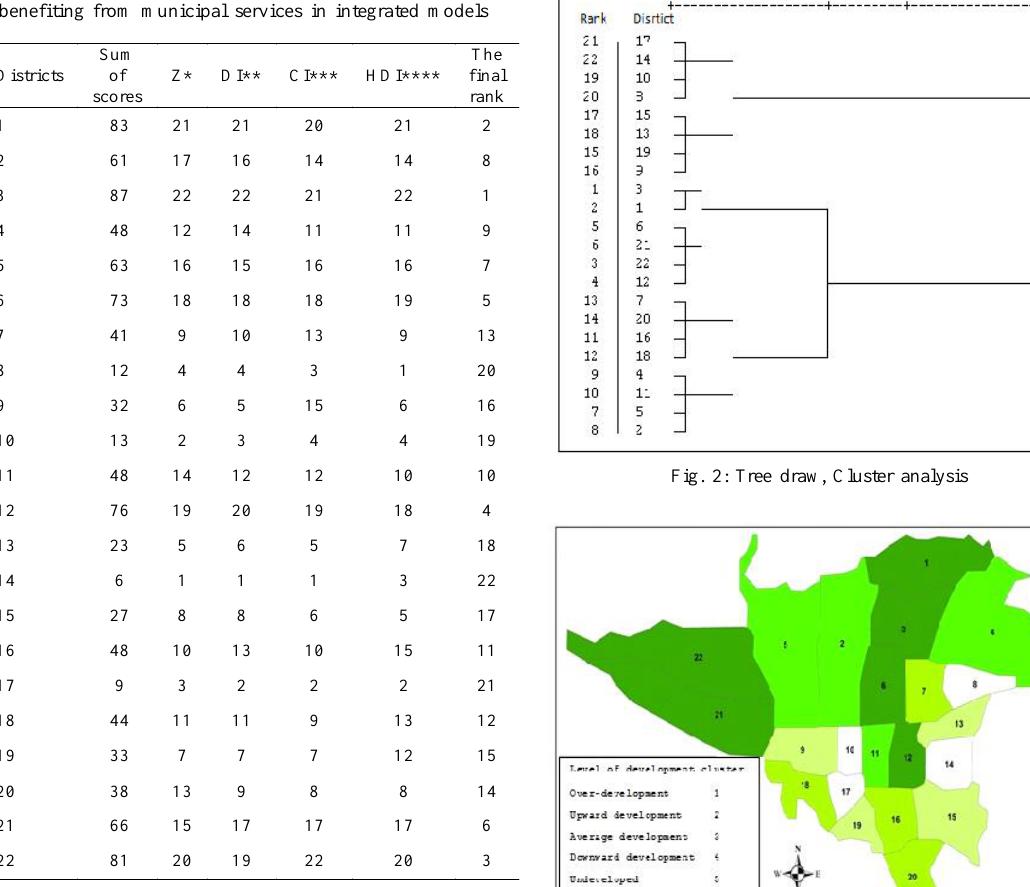
Table 7: Ranking of districts of Tehran, in terms of benefiting from municipal services in integrated models